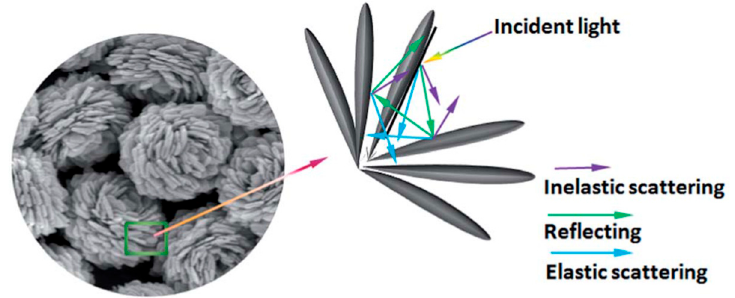
Figure 15. Schematic diagram of the reflecting and scattering effects in hierarchical microspheres [94]. Copyright 2014 The Royal Society of Chemistry.